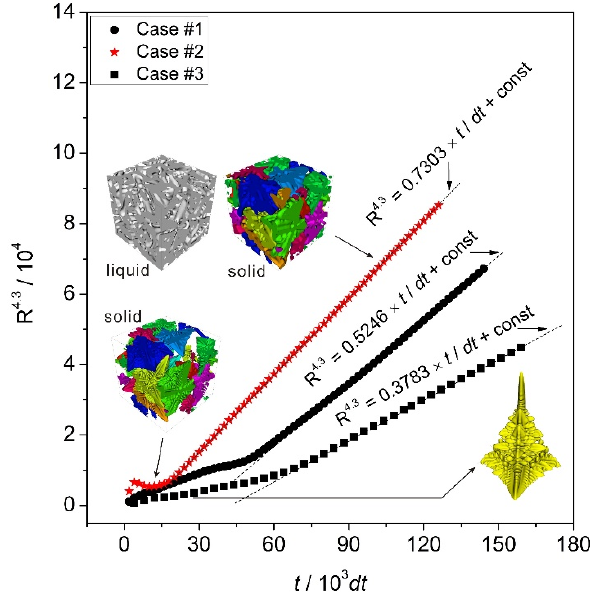
Figure 11. Comparison between simulation and fitted results for different simulation cases.